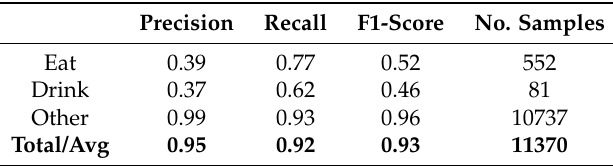
Table 8. Complete validation set recognition